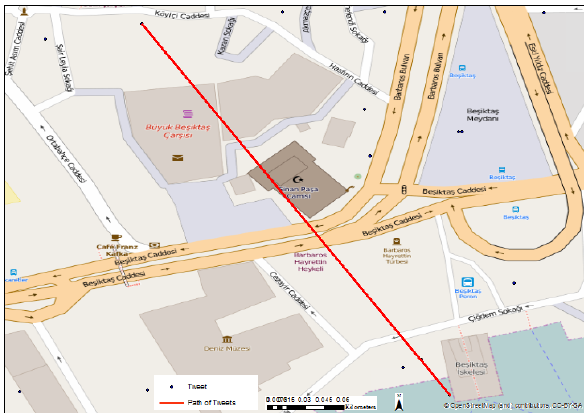
Figure 10. Pedestrian Travel Path Estimation Case